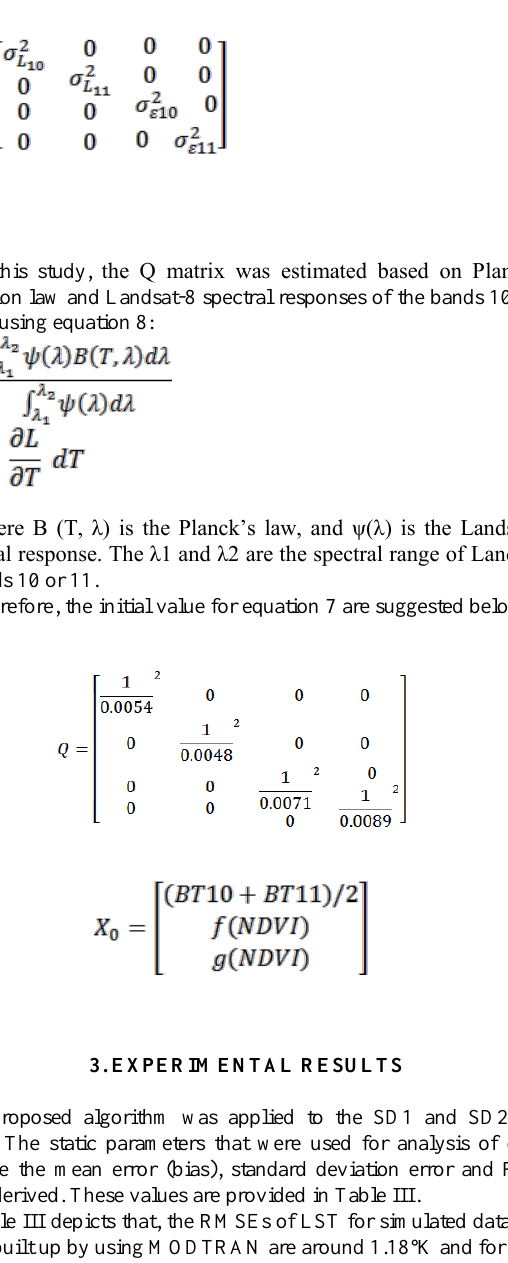
Table III. Result of the validation using simulated